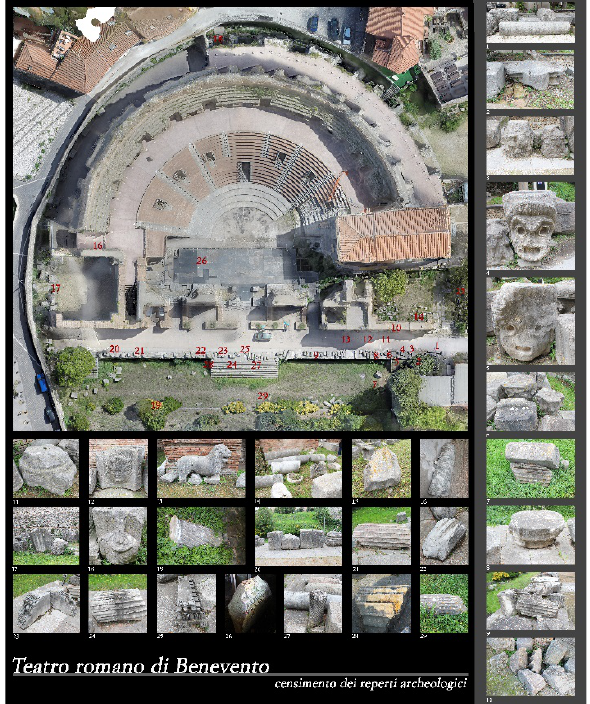
Figure 3: Census and survey of archaeological